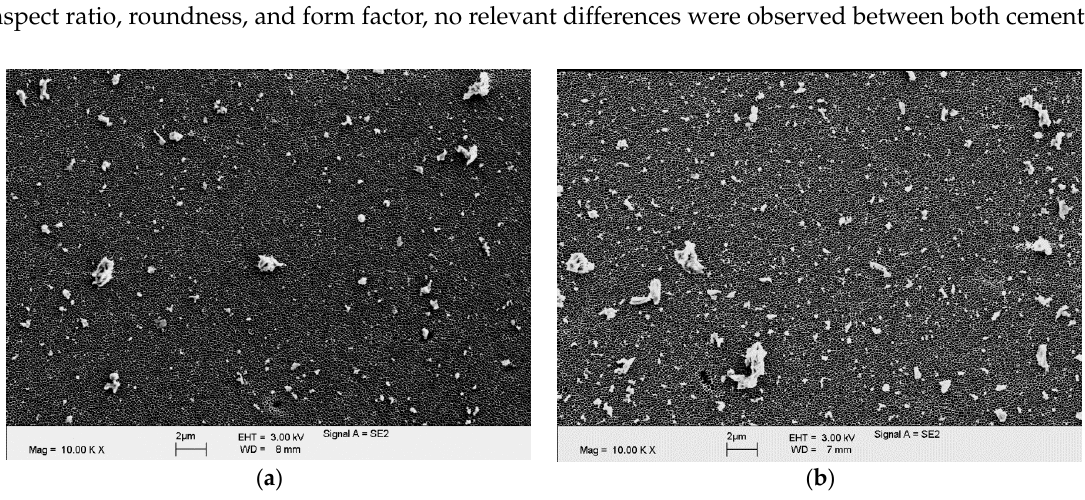
Figure 6. Isolated wear particles of the CC-cement ( a ) and the BS-cement ( b ). Table 3. Characteristics of the two investigated spacer cements.